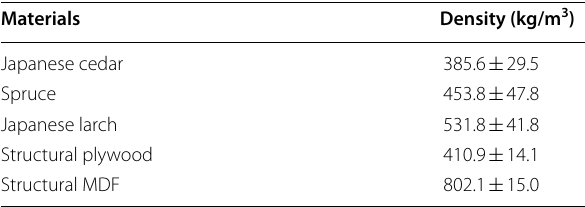
Table 1 Average and standard deviation of densities of